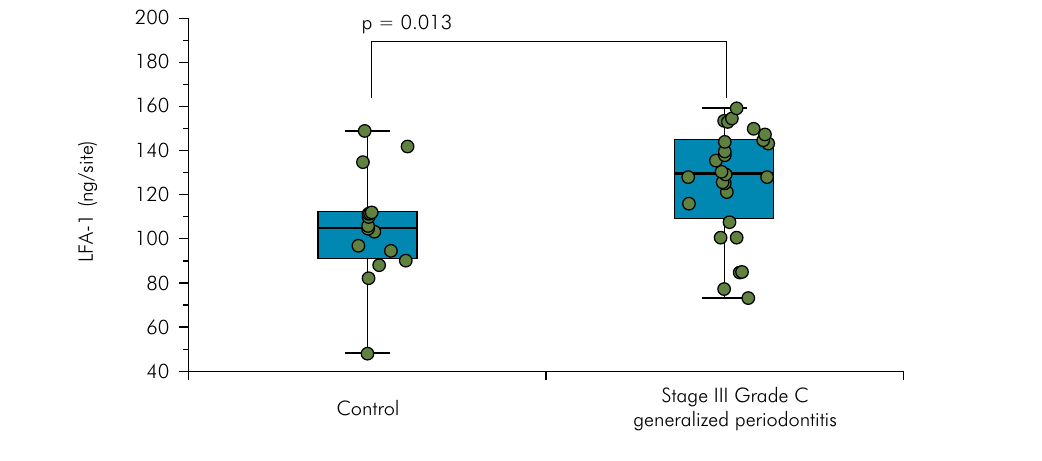
Figure 1. GCF levels of LFA-1 for periodontitis and control groups.